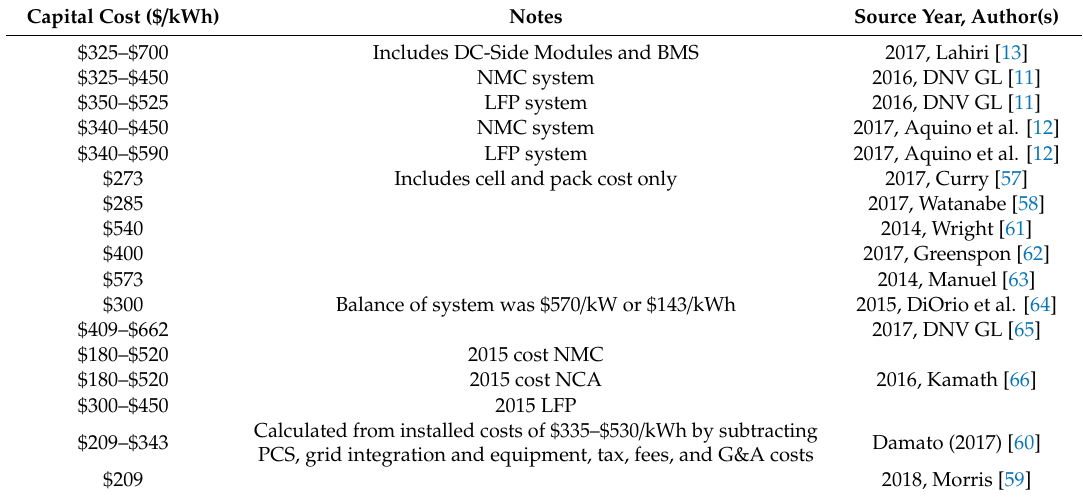
Table 11. Capital cost estimates—lithium-ion